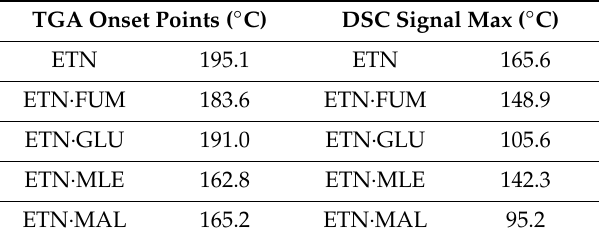
Table 4. TGA onset points and DSC signal max values for pure ETN and all obtained adducts. See Figures